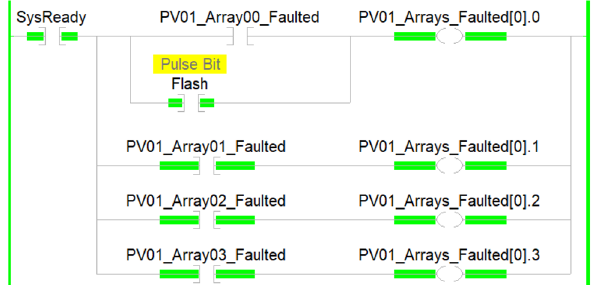
Fig. 12 Misleading diagnostics by adding a flashing bit